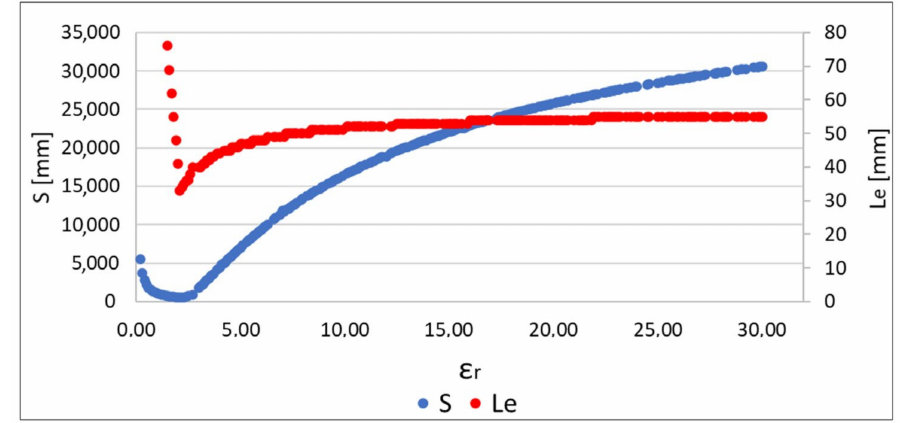
Figure 14. The value of S function and localization error ( Le ) depending on model permittivity.